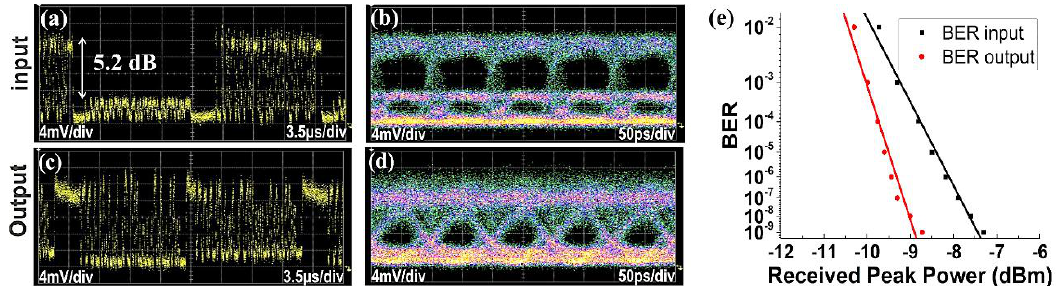
Figure 5. Experimental results for 10 Gb/s packets and 25 km fiber transmission ( a ) input trace (3.5 μs/div), ( b ) input eye diagram (50 ps/div) ( c ) BMWC output trace, ( d ) BMWC output eye diagram and ( e ) BER measurements without the BMWC (input) and with the BMWC (output). All traces and